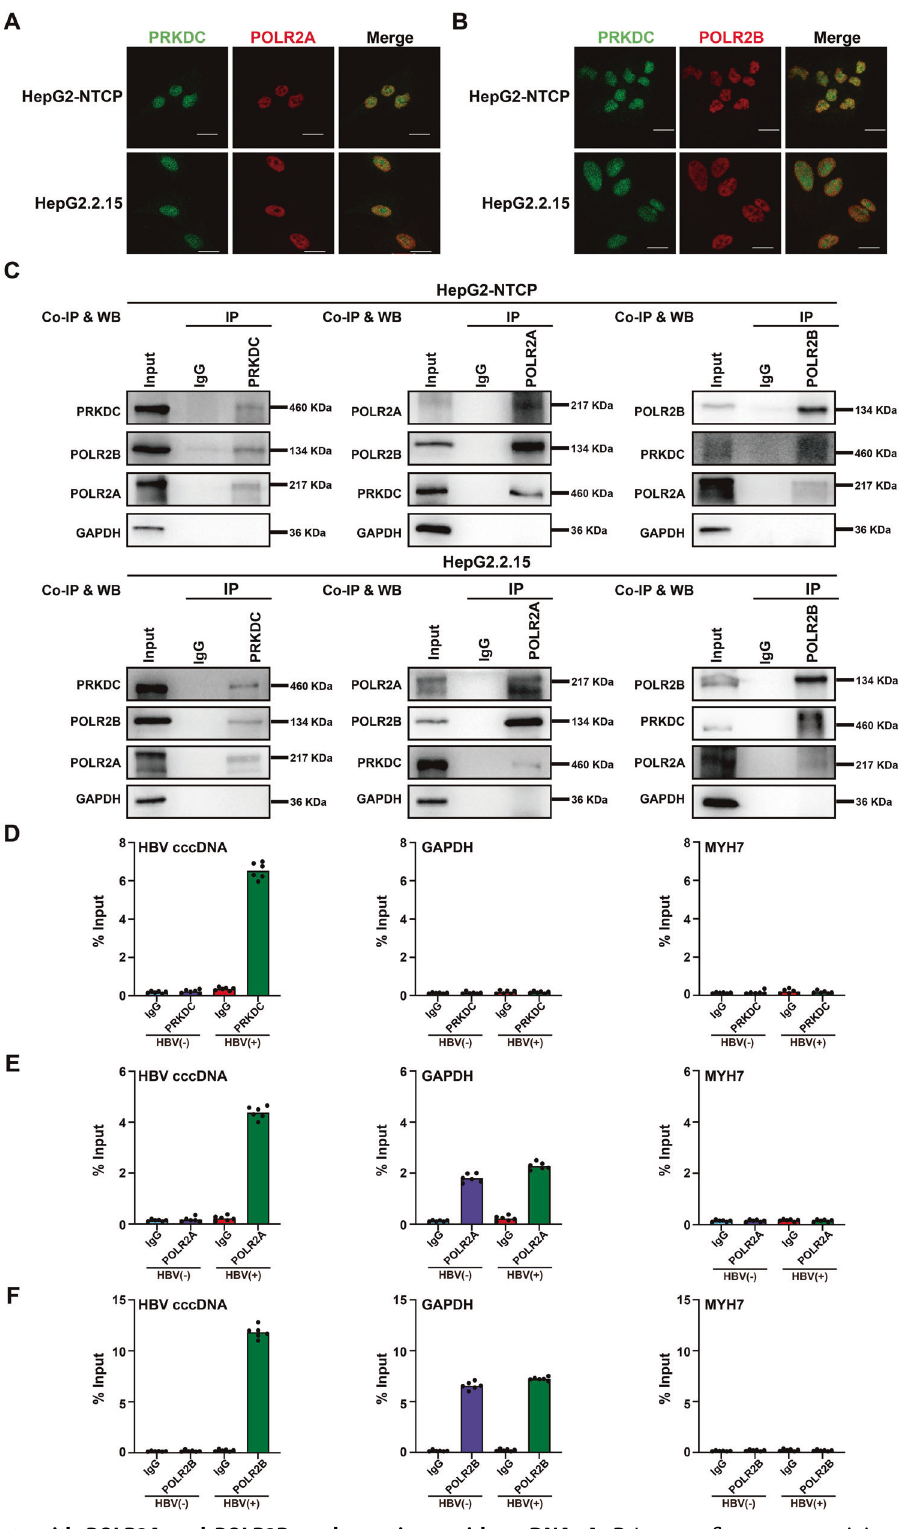
Fig. 5 PRKDC interacts with POLR2A and POLR2B, and associates with cccDNA. A, B Immuno fl uorescent staining demonstrates partial colocalization of PRKDC (green) and POLR2A ( A ) or POLR2B ( B ) in HBV-infected HepG2-NTCP and HepG2.2.15 cells. Scale bar, 10 μ m. C Endogenous co-immunoprecipitation with PRKDC (left), POLR2A (middle), and POLR2B (right) was carried out in HBV-infected HepG2-NTCP and HepG2.2.15 cells using indicated antibodies and blotted with speci fi c antibodies. D – F Cross-linked chromatin from HBV-infected or non- HBV-infected HepG2-NTCP cells was immunoprecipitated with PRKDC ( D ), POLR2A ( E ), and POLR2B ( F ), and the corresponding IgG was used as a control, followed by PCR quanti fi cation of HBV cccDNA and the promoter of GAPDH and MYH7 using speci fi c primers. The results are displayed as the percentage of